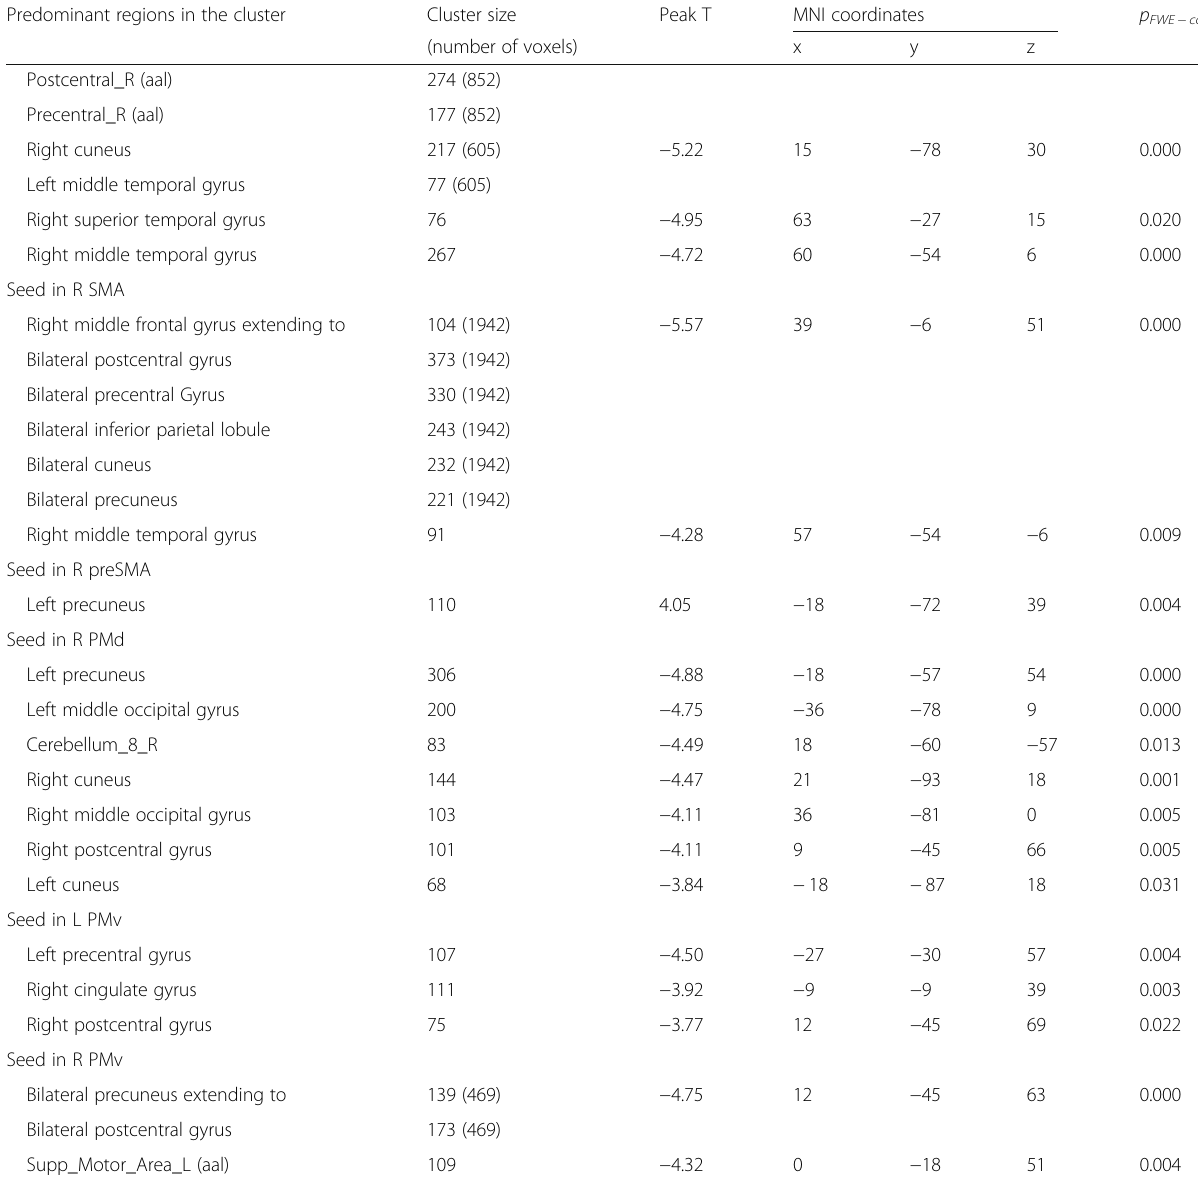
Table 2 Brain regions with decreased functional connectivity (FC) in migraine without aura (MWoA) compared to healthy controls (HC)